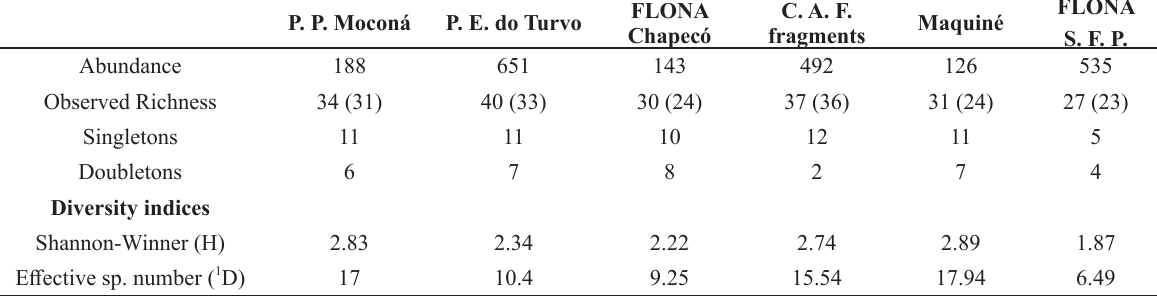
Inventory data and diversity indices of Pentatomidae comparing six protected areas in the Atlantic Forest (Between brackets the number of species used to calculated de SCI, ACI and SCV).